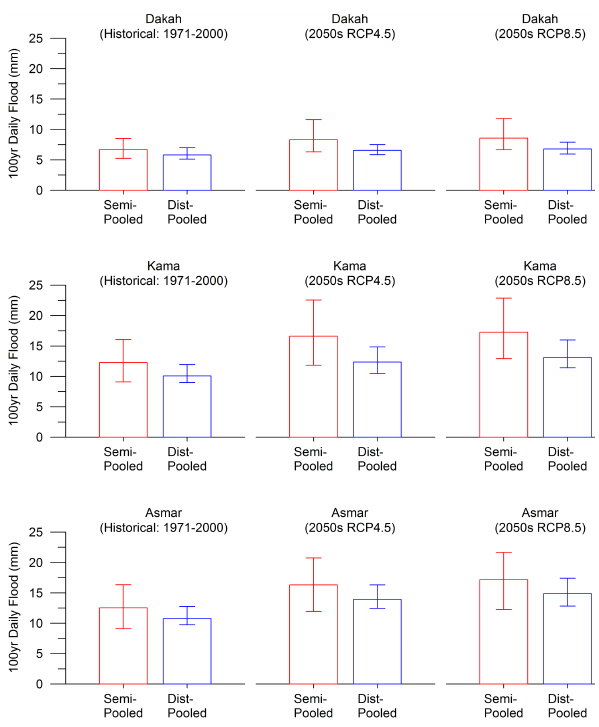
Figure 12. Comparison of GCM average 100-year daily flood events derived from the semi-distributed and distributed pooled cal- ibrations. The uncertainty range is from 50 trials of the model cali-